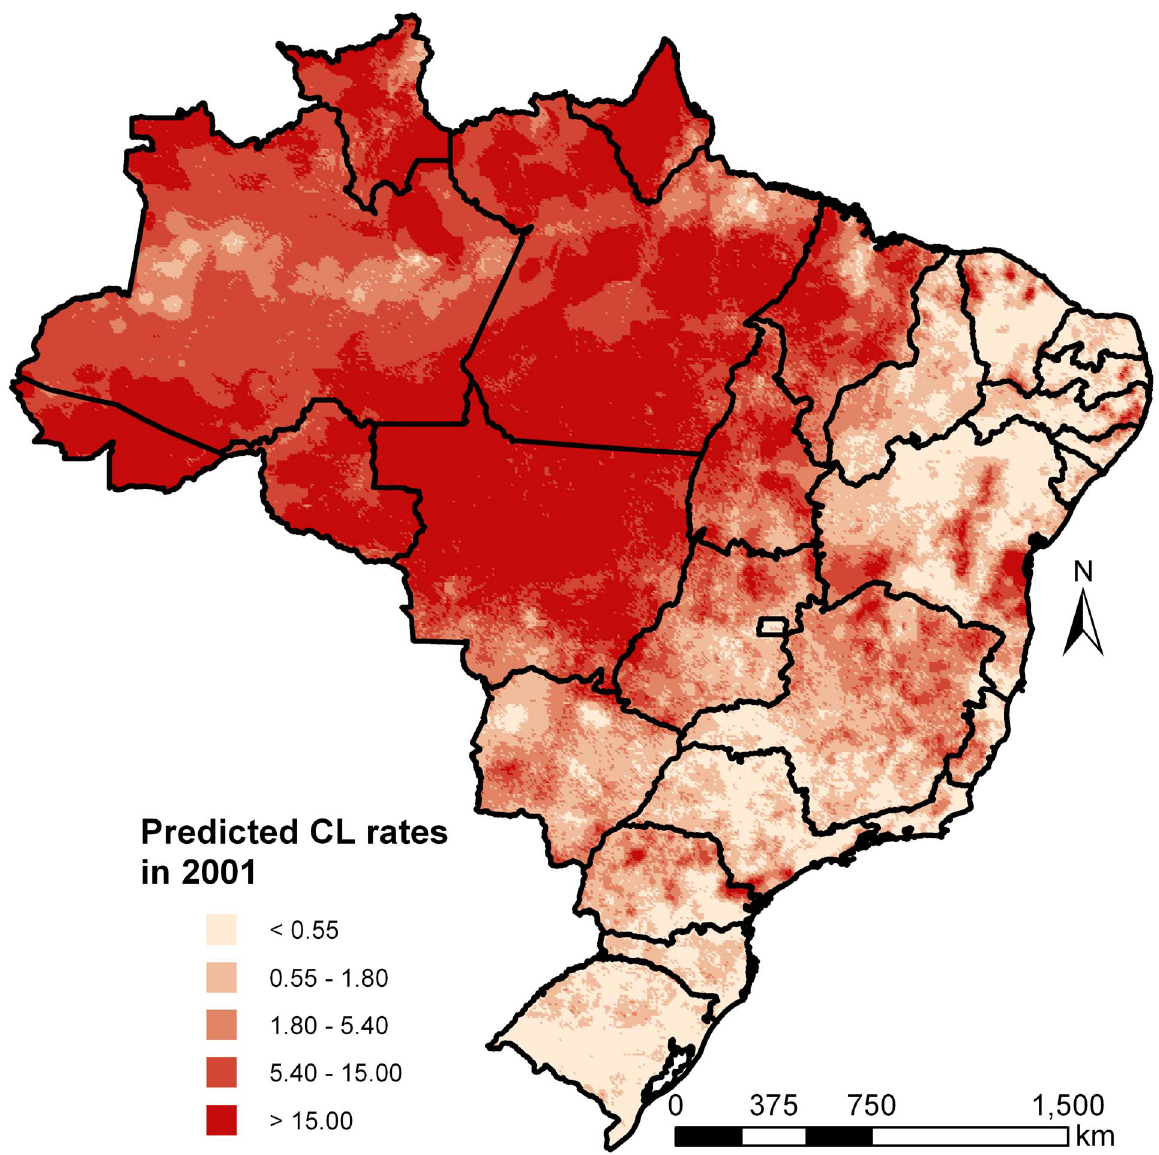
Figure 5. Geostatistical model-based predicted incidence rates per 10,000 for cutaneous leishmaniasis in Brazil in 2001.